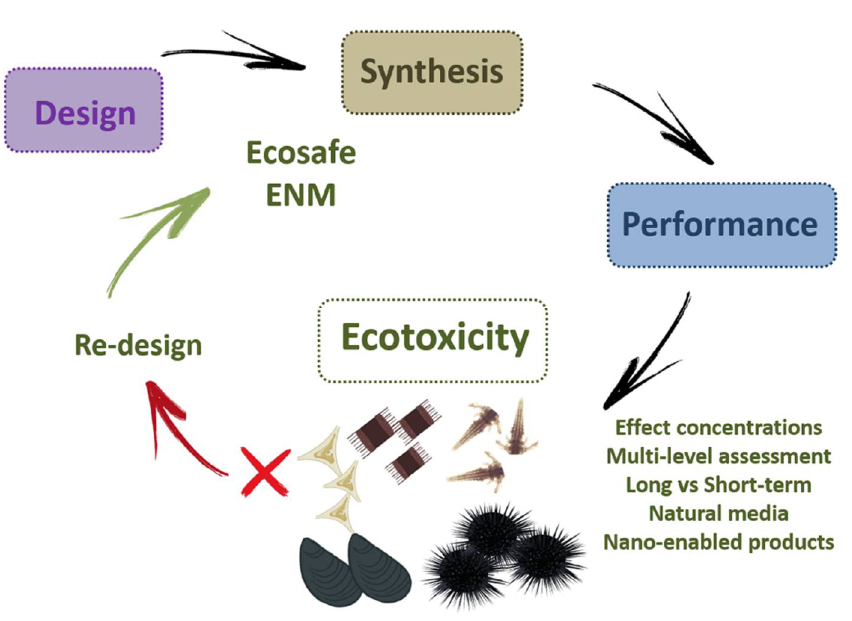
Figure 7. The proposed eco-design framework of ENMs. Ecotoxicity should be included in the design framework together with performance from synthesis to production. Reprinted from ref.